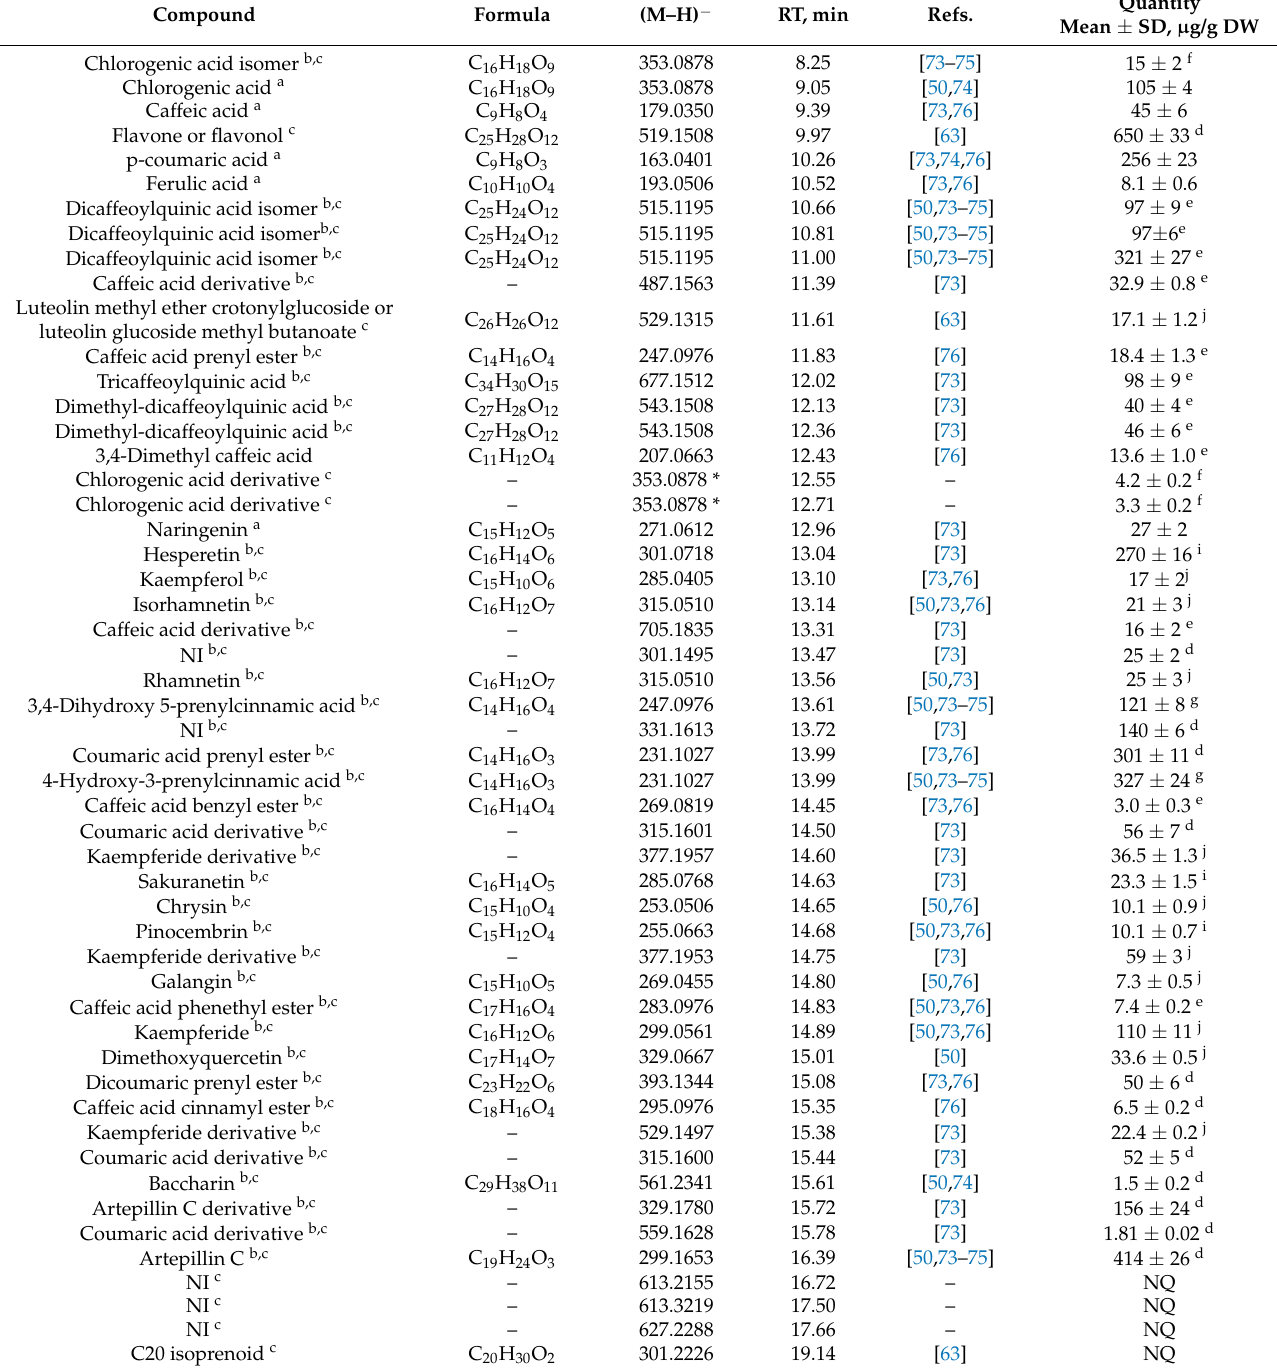
Table 4. Compounds identified in the green propolis